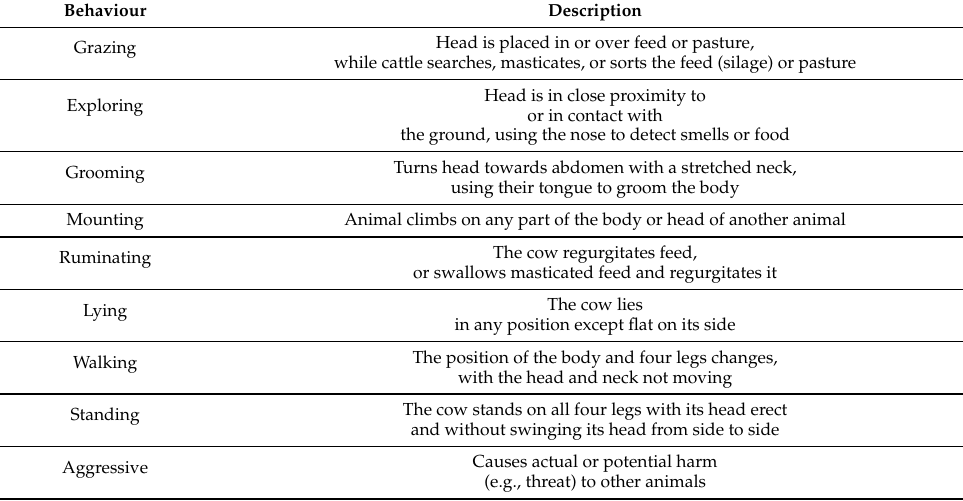
Table 2. Main cattle behaviour